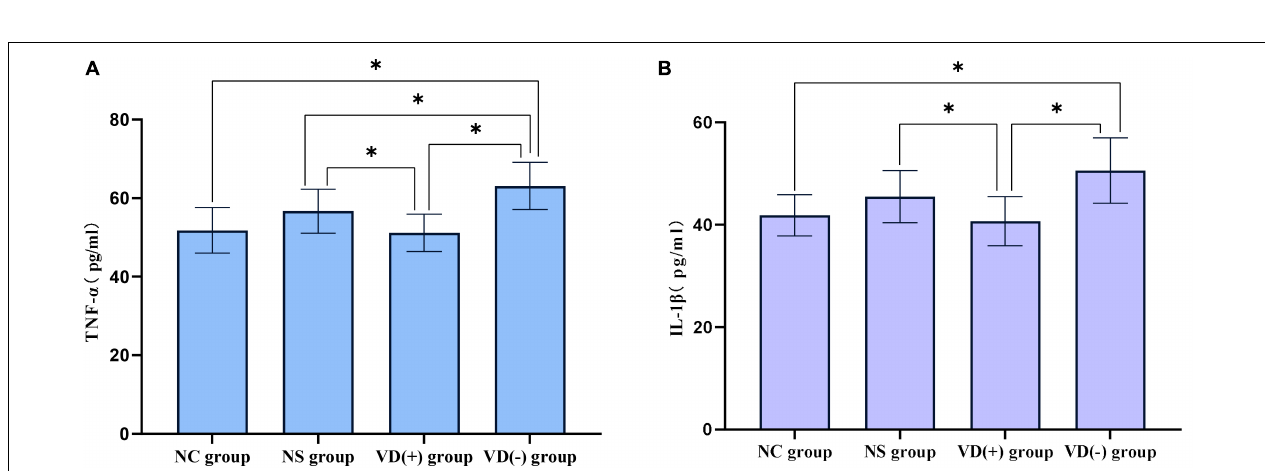
FIGURE 6 | Comparison of inflammatory factors between the control group and the anesthesia treatment group. (A) Comparison of TNF- α : between groups, ∗ P < 0.05. (B) IL-1 β comparison: comparison between groups, ∗ P < 0.05.